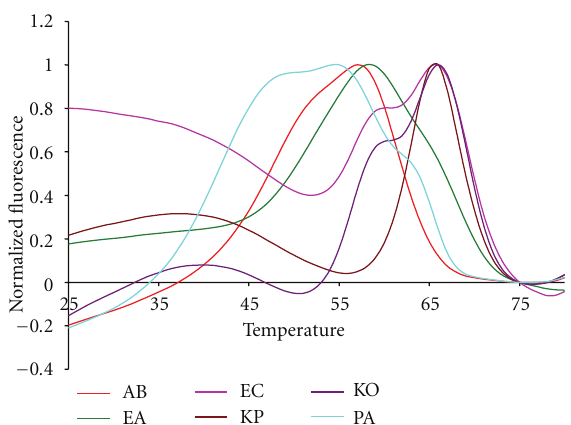
Figure 4: The normalized anneal curve showing all Gram negative 16S targets in the Quasar channel with their highest peak normal- ized to 1.0.